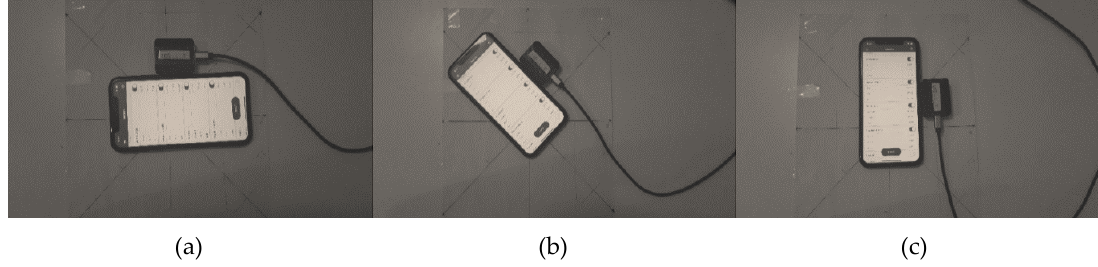
Figure 3. Module MPU-9250 and smartphone iPhone 11 rotation trajectory for heading test: ( a ) 180 heading degree; ( b ) 135 heading degree; ( c ) 90 heading degree. Table 1. Comparison of error between iPhone 11 and Samsung S10’s AHRS algorithms.